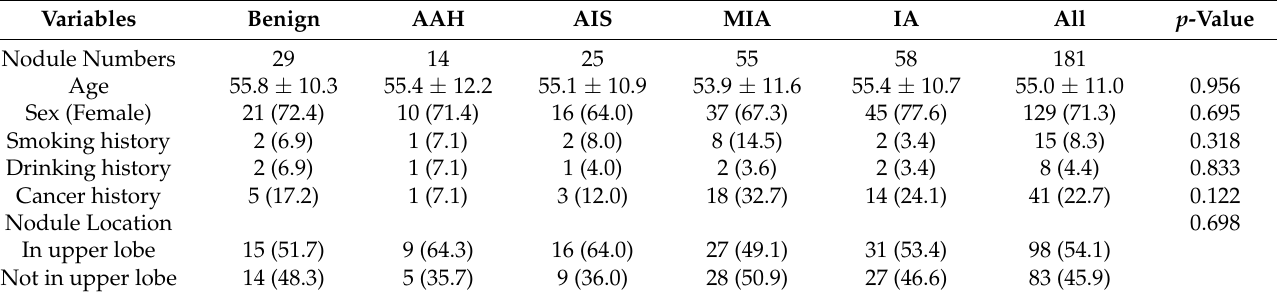
Table 1. Demographic data and nodule